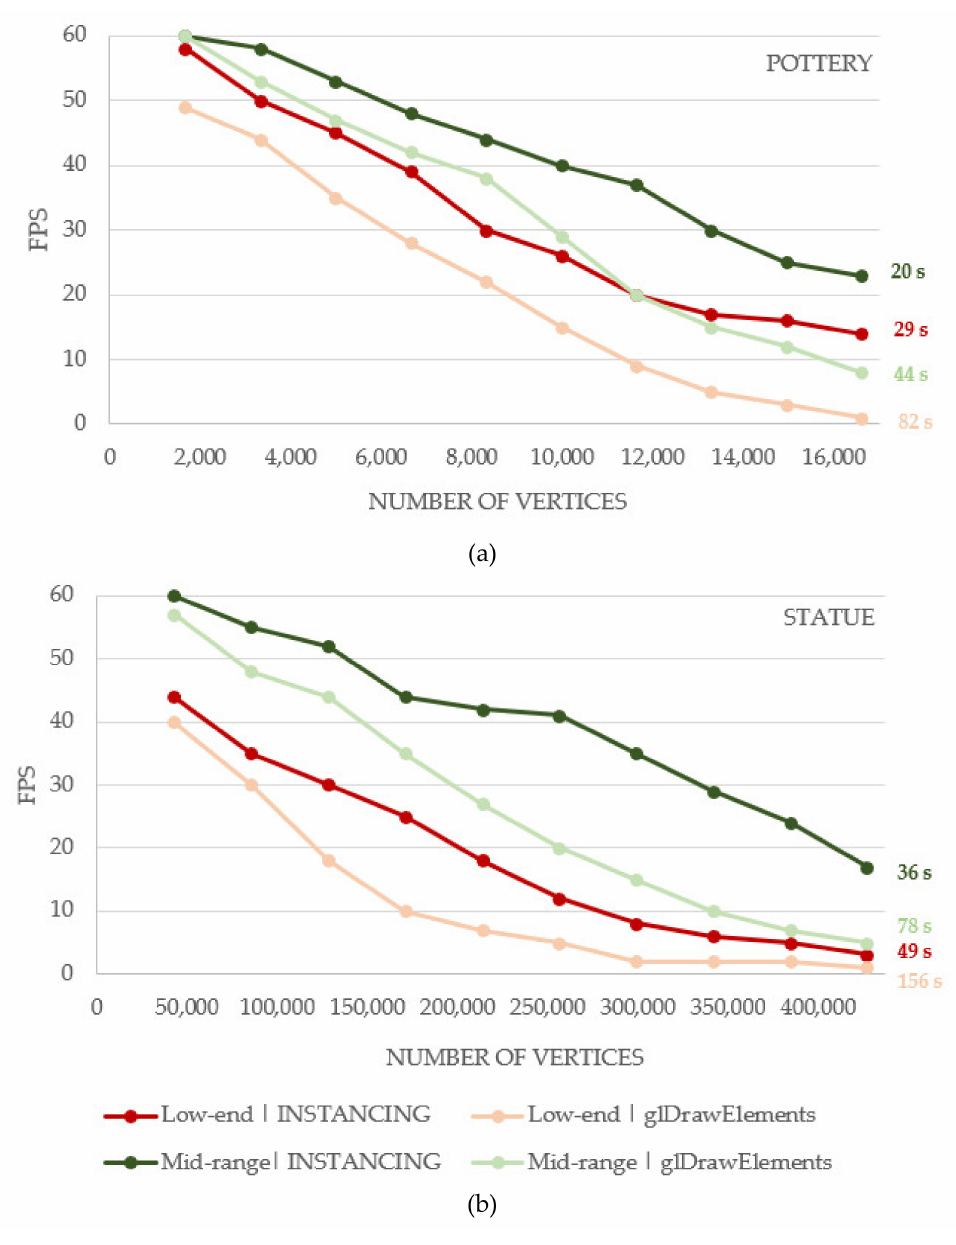
Figure 11. ( a ) Number of vertices being drawn per frame and achieved framerate on FPS; ( b ) FPS for ten models applying glDrawElements and Instancing methods at the low-end and mid-range devices. Table 11. Average frame rate and total rendering time of ten meshes of POTTERY and STATUE using a combination of rendering techniques and buffer storage on the low-end